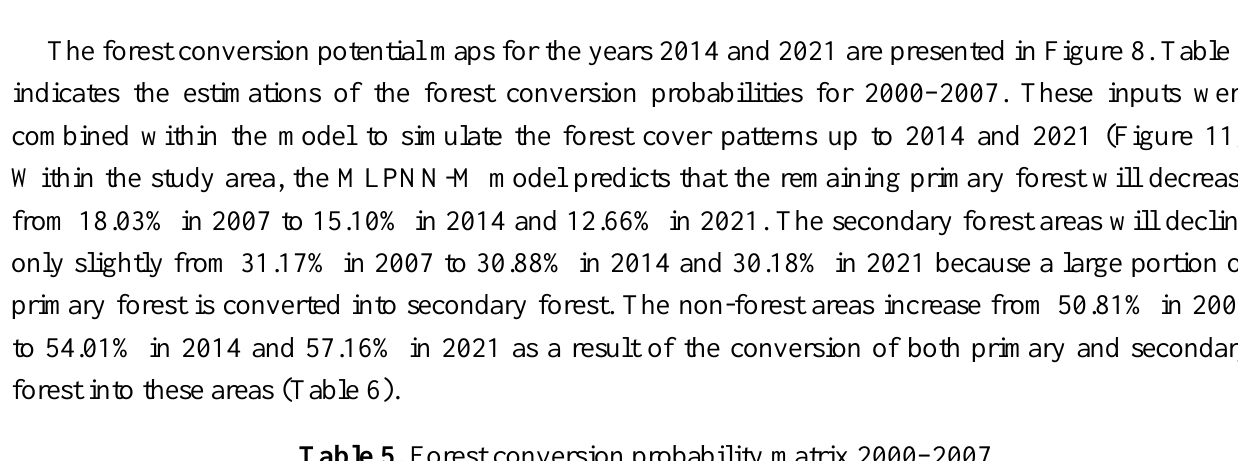
Table 5. Forest conversion probability matrix